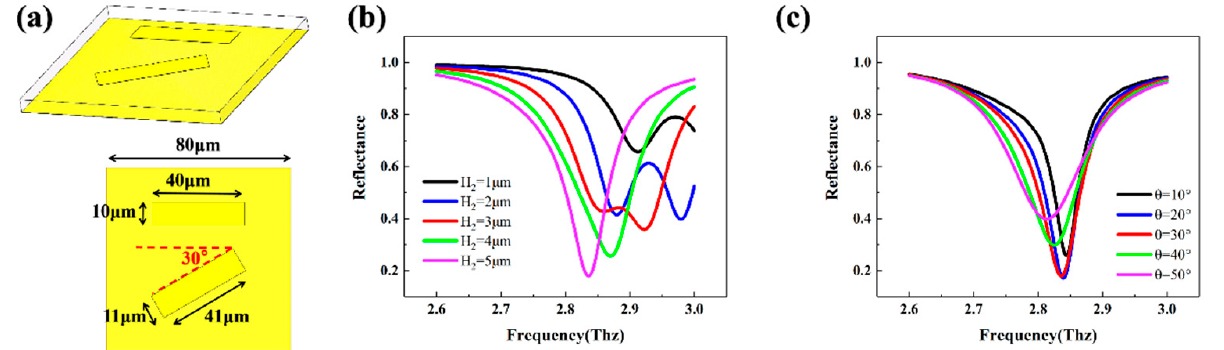
Figure 8. ( a ) Schematic diagram of the chiral structure. The tilted rectangle is 41 μ m long, and 11 μ m wide. The optimized thickness of the medium is 5 μ m. ( b ) The effect of the thickness and length of the dielectric layer on the reflectivity of the chiral structure. ( c ) The effect of resonance metal rotation angle on the reflectivity of chiral structures.